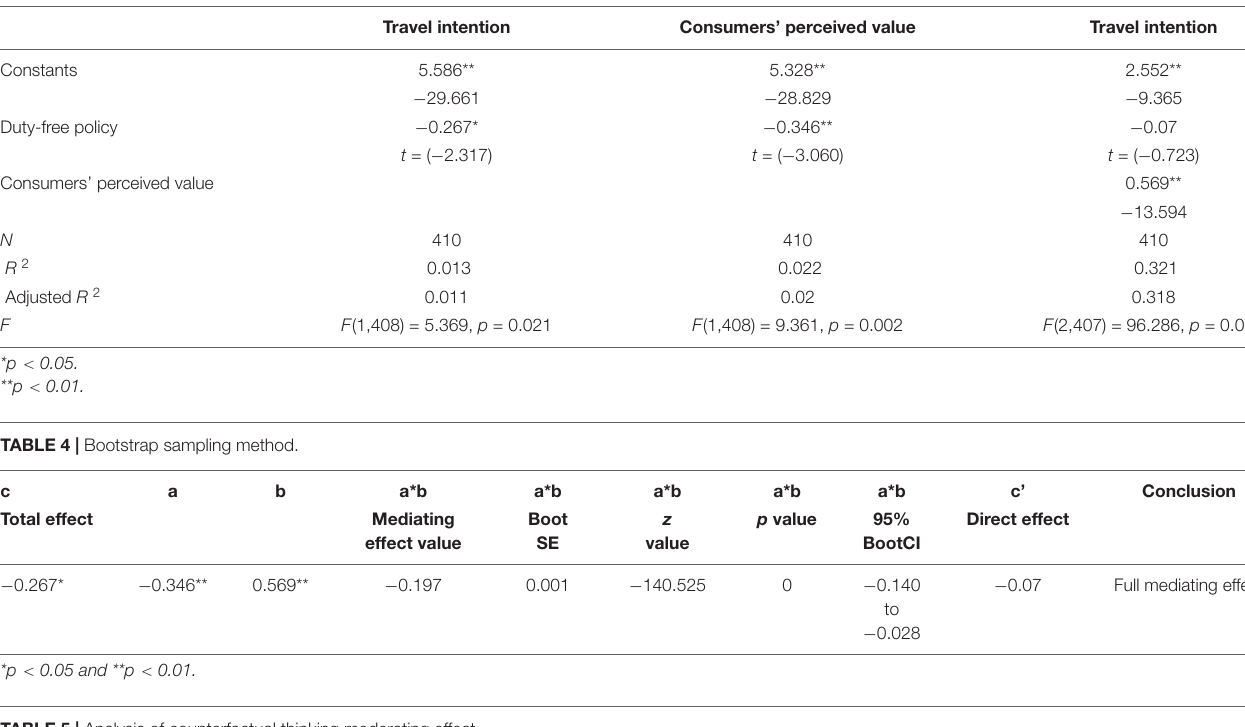
TABLE 5 | Analysis of counterfactual thinking moderating